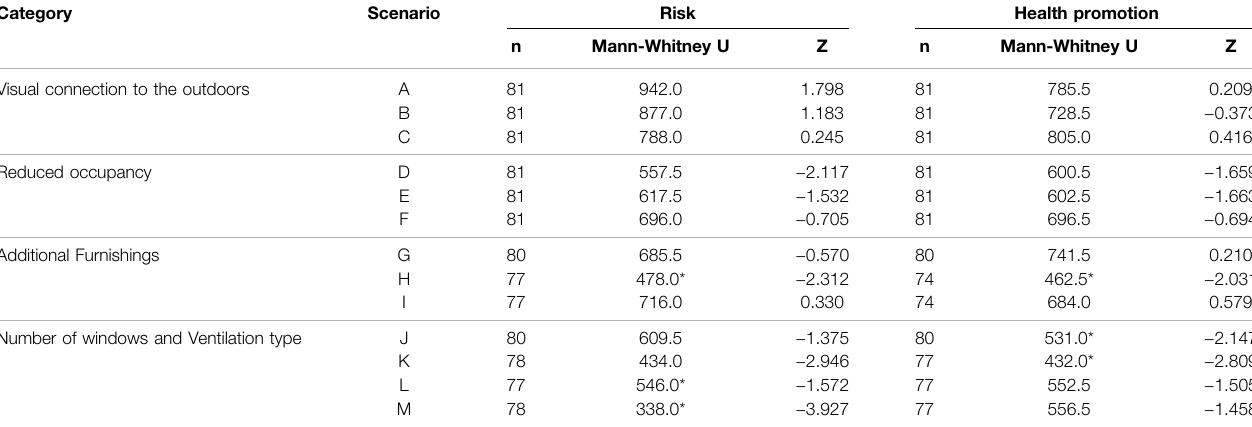
TABLE 2 | Mann-Whitney tests comparing scenarios between the United States and Colombia. Signi fi cance of p < 0.05 is indicated with *. Category Scenario